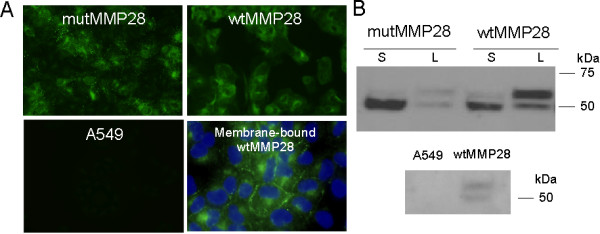
Representative images demonstrating expression of recombinant, V5-tagged wild-type and mutant MMP28 in A549 cells. A. Immunofluorescence (IF) using FITC-conjugated anti-V5 antibody. Bottom right image demonstrates localization of MMP28 to the plasma membrane. B. Western blot (WB) of supernatants (S) and cell lysates (L) from representative mutant and wild-type clones. Membranes were stained with anti-V5 HRP. The larger band (58 kDa) represents the pro-form, which is more abundant in the cell lysate, and the smaller band (48 kDa) represents the secreted active form, which is more abundant in the supernatant. A549 cells had no staining by IF or WB using the V5 antibodies.